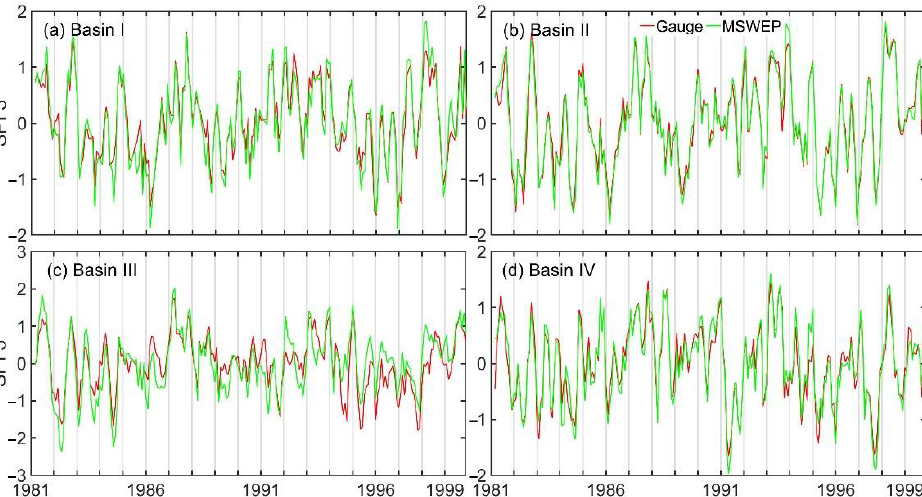
Figure 6. The SPI3 temporal evolution of ground sites and MSWEP in each basin. To analyze the capability of MSWEP to capture drought and wet conditions, this study calculated the CC, RB, and RMSE of SPI3_mswep site by site (Figure 7) by using SPI3_stn as a benchmark. It can be seen that the correlation between MSWEP and site data is relatively high, with the average values reaching 0.79 and the highest CC value reaching 0.99. MSWEP showed an underestimation of SPI3 at most sites in the four basins, with only eight sites in Basin II and five sites in/around Basin I being overestimated. There are no obvious variations between the four basins in respect to RMSE.